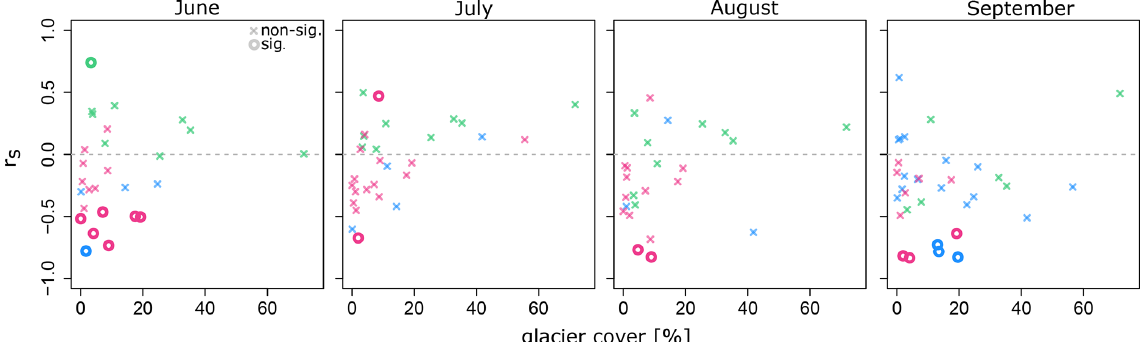
Figure 9. Time trends of C for each catchment calculated as Spearman rank correlation coefficients ( r s ) between C and year of the WD event. Norwegian catchments are indicated in green, catchments in the European Alps in blue, and Canadian catchments in pink. Circles indicate significant trends ( α = 0 .